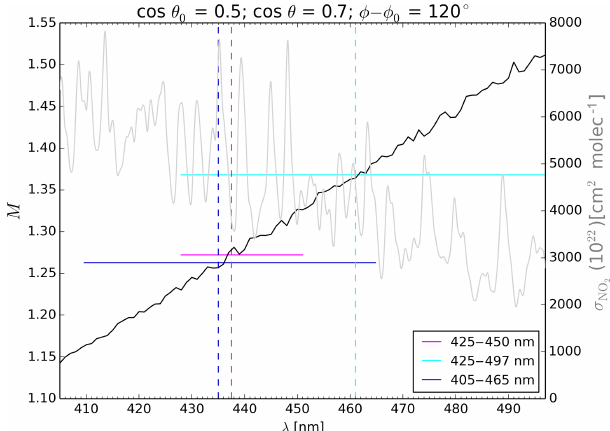
Figure 6. NO 2 tropospheric air mass factor (black) as a function of wavelength computed with DAK for a polluted boundary layer for a specific viewing geometry ( θ = 60 ◦ , θ o = 45.6 ◦ ). Horizontal lines show averaged multi-wavelength AMF for different fitting windows (purple, 425–450nm, blue 405–465nm and light blue 425–497nm). The grey line shows NO 2 absorption cross section from Vandaele et al. (1998) at 220K. A midlatitude standard atmosphere was used including O 3 . The AMF was computed for a polluted boundary layer with 16 × 10 15 molec.cm − 2 , without aerosols, a boundary layer height of 1km and surface albedo of 0.05. The non-smooth behaviour of the black line is because the spectral resolution of the AMF is not sufficient to resolve the NO 2 cross section used in the calculation. If a constant cross-section value is used in the RTM for calculating TOA reflectance, the increasing AMF with wavelength would be spectrally